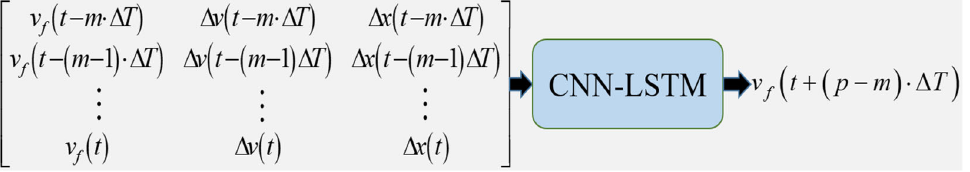
Figure 5. Framework overview.